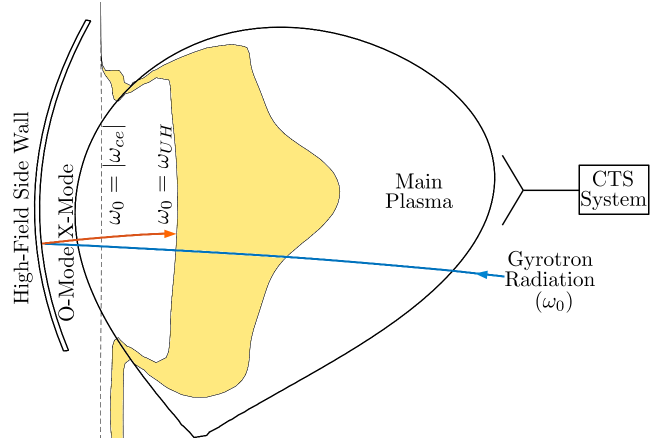
Figure 1. Experimental setup in ASDEX Upgrade discharge #34575. Gyrotron radiation, with ω 0 = 2 π × 105GHz, is injected in O-mode from the low-field side, partially transmitted by the (optically thin) ECR ( ω 0 = | ω ce | ) and reflected by the high-field side wall. After the reflection, part of the radiation re-enters the plasma in X-mode; if the ECR is not optically thick for the X-mode radiation, a significant amount of power may reach the UHR ( ω 0 = ω UH ) where PDIs can be triggered due to field enhancement e ff ects. The electromagnetic emission / scattering in O-mode at frequencies close to ω 0 is measured using the fast acquisition CTS system. No propagating X-mode radiation exists in the shaded region.